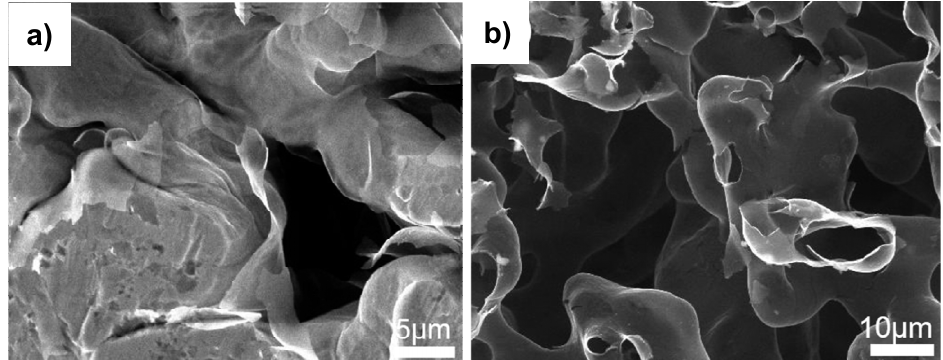
Figure 5. ( a ) SEM image and ( b ) the magnified SEM image of the 3D graphene network after evaporating copper template. Reprinted with permission from ref. [21]. Copyright 2017 American Chemical Society.